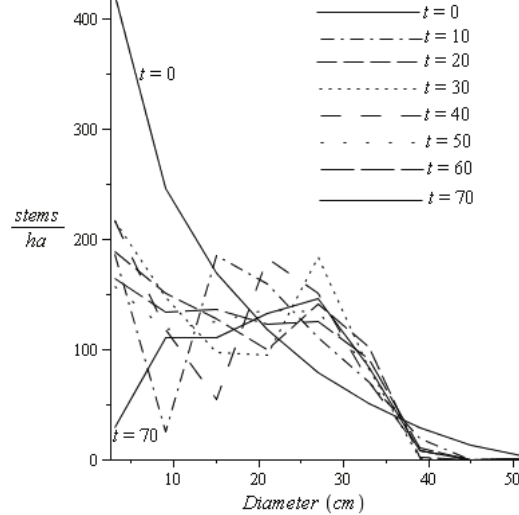
Figure 5. Evolution of the diameter distribution with the economically optimal harvesting strategy throughout a harvest cycle of 70 years for Quality I, G = 24 m 2 /ha, R = 520 stems/ha and i =